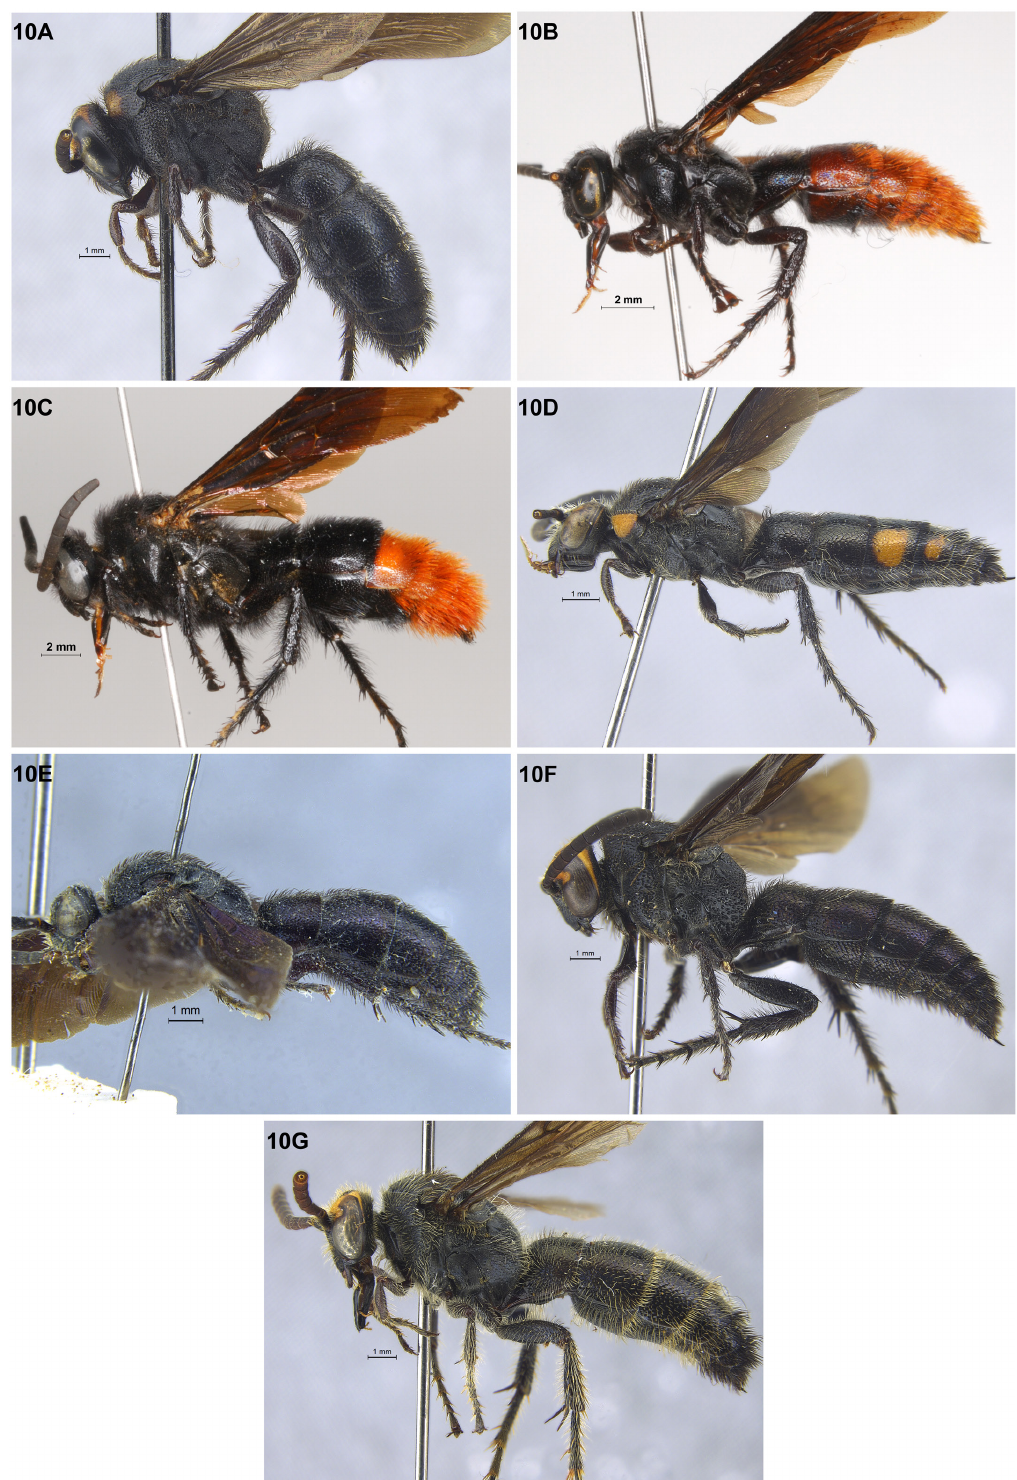
Fig. 10. Males, lateral habitus. A . Carinoscolia junnanensis (Betrem, 1928). B . Liacos erythrosoma (Burmeister, 1854). C . Megascolia azurea (Christ, 1791). D . Scolia binotata Fabricius,